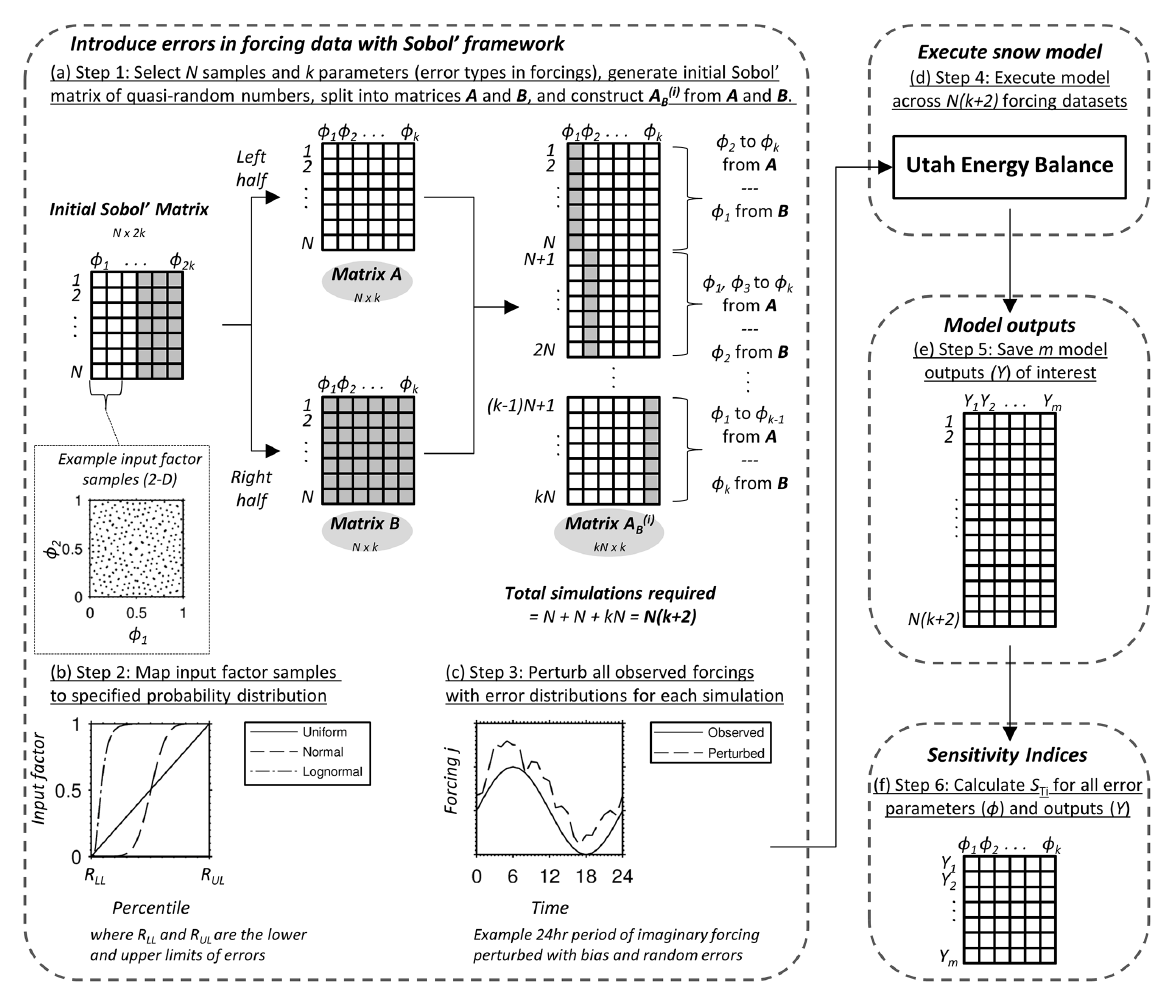
Figure 2. Conceptual diagram showing methodology for imposing errors on the forcings with error parameters ( φ i ) within the Sobol’ sensitivity analysis framework, and workflow for model execution and calculation of sensitivity indices on model outputs ( Y